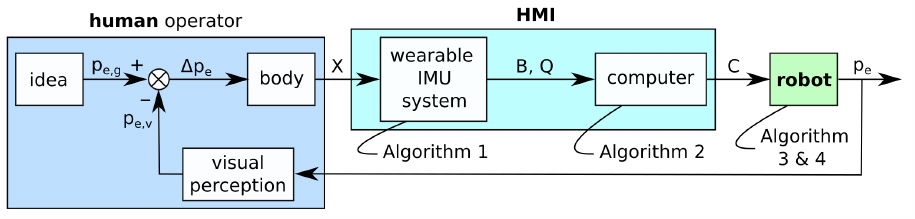
Figure 1. The control